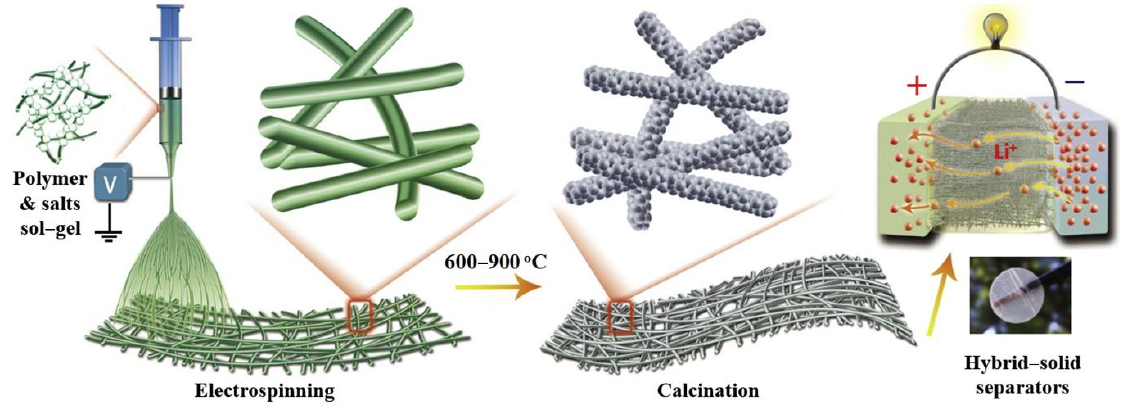
Figure 2. Fabrication process of nanofibers (Reprinted with permission from Ref. [21]).